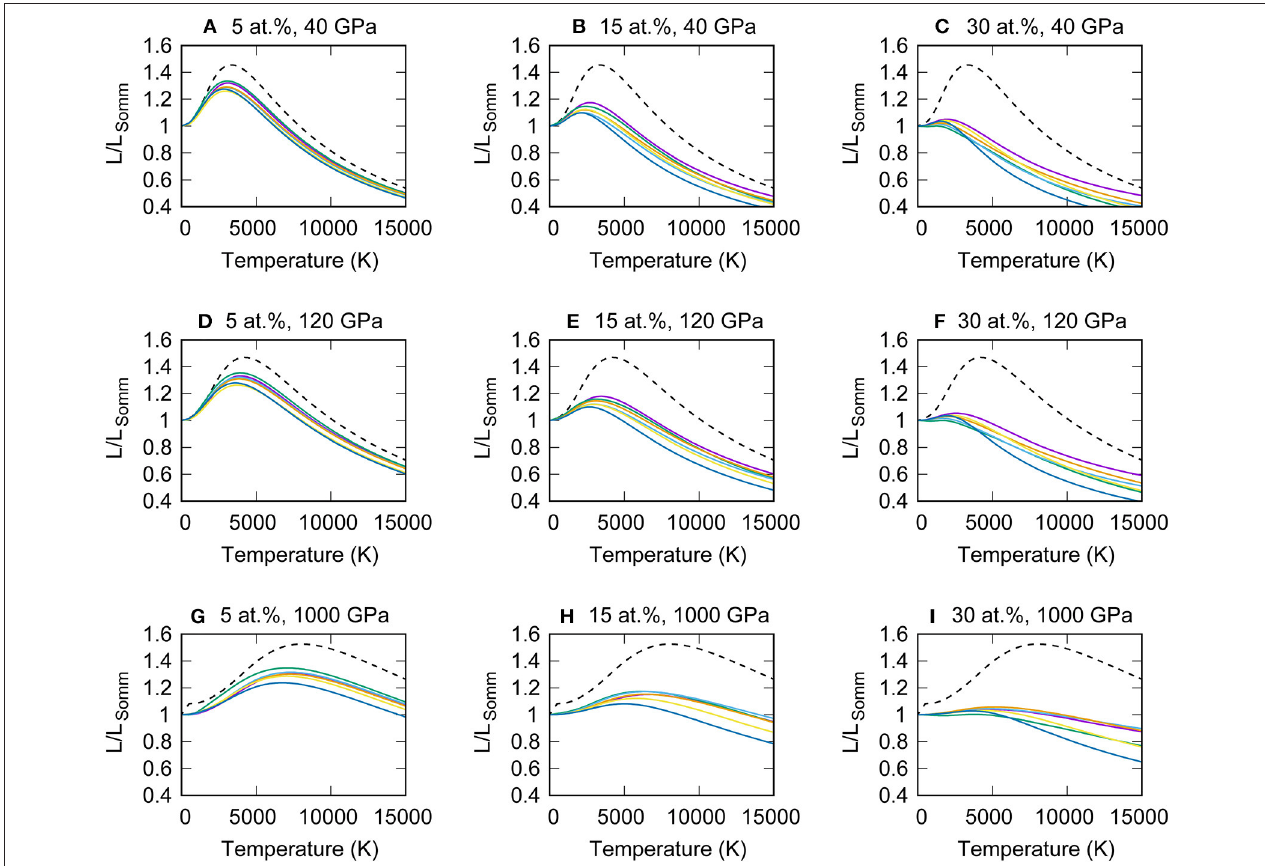
FIGURE 8 | The deviation of the Lorenz number from the Sommerfeld value predicted by the electronic specific heat of hcp Fe 0.95 X 0.05 , Fe 0.85 X 0.15 and Fe 0.70 X 0.30 , where X is Si (purple), Ni (green), S (cyan), C (orange), N (yellow) and O (blue) at the volume of V = 19.10 Å 3 ( P ∼ 40 GPa at 300K) (A–C) , 16.27 Å 3 ( P ∼ 120 GPa at 300K) (D–F) and 9.80 Å 3 ( P ∼ 1,000 GPa at 300K) (G–I) . Black broken lines are pure Fe for